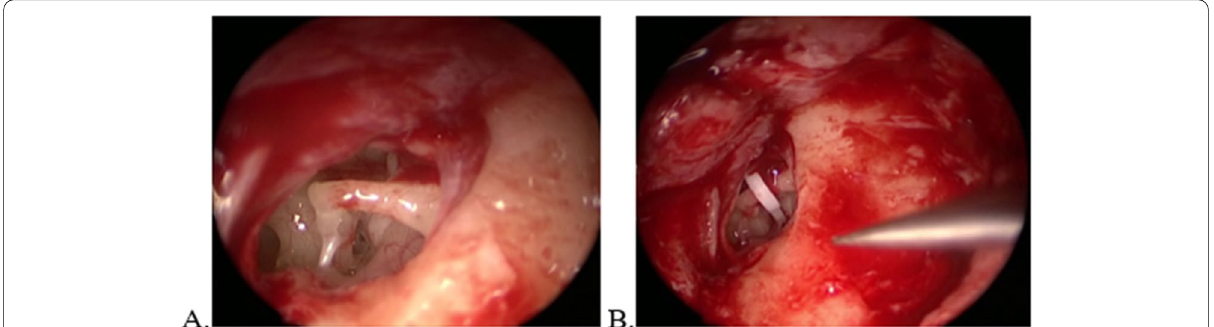
Fig. 5 A Endoscopic view of the stapedotomy in the oval window (reverse fish technique). B Endoscopic view of the prothesis in place with presence of tortuous